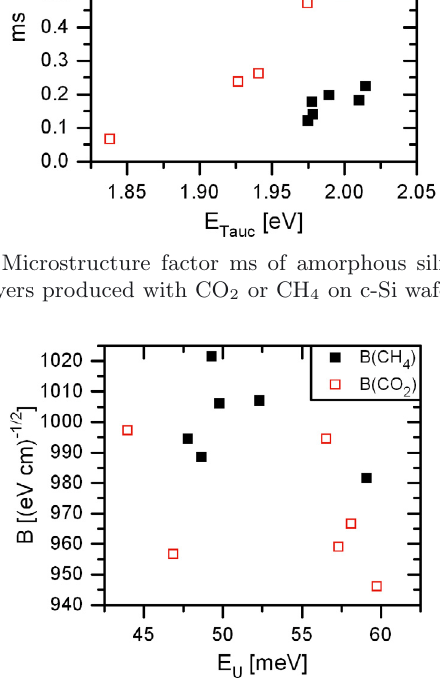
Fig. 8. Tauc slope parameter B of amorphous silicon alloy single layers produced with CO 2 or CH 4 against Tauc